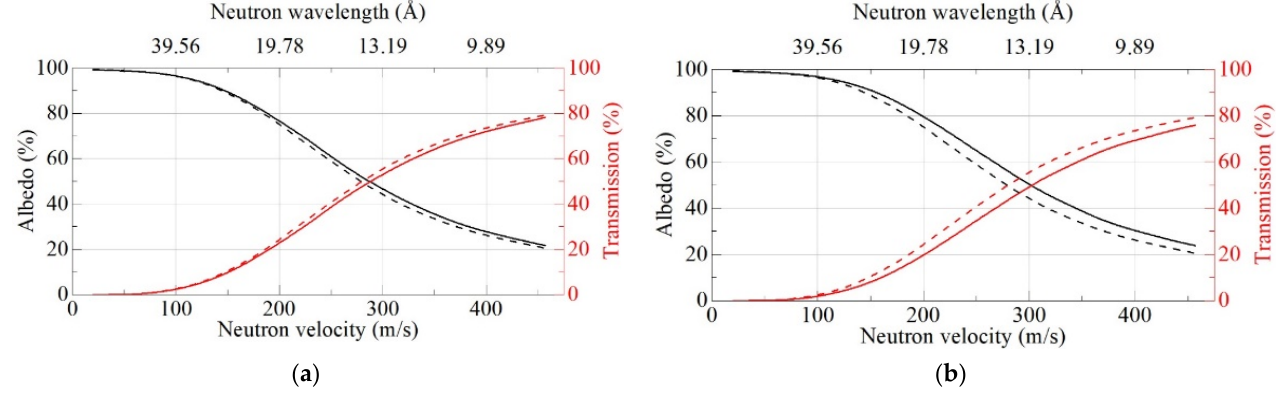
Figure 8. Neutron albedo (black lines) and transmission (red lines) for a flat layer of DF-DNDs (dashed lines) and S-DNDs (solid lines) versus neutron velocity [m/s]. ( a ) The layer thickness is 3 cm and the powder density is 0.56 g/cm 3 for both samples; ( b ) the layer thickness is 3 cm and the powder density is 0.56 g/cm 3 for DF-DNDs, and it is 0.67 g/cm 3 for S-DNDs.